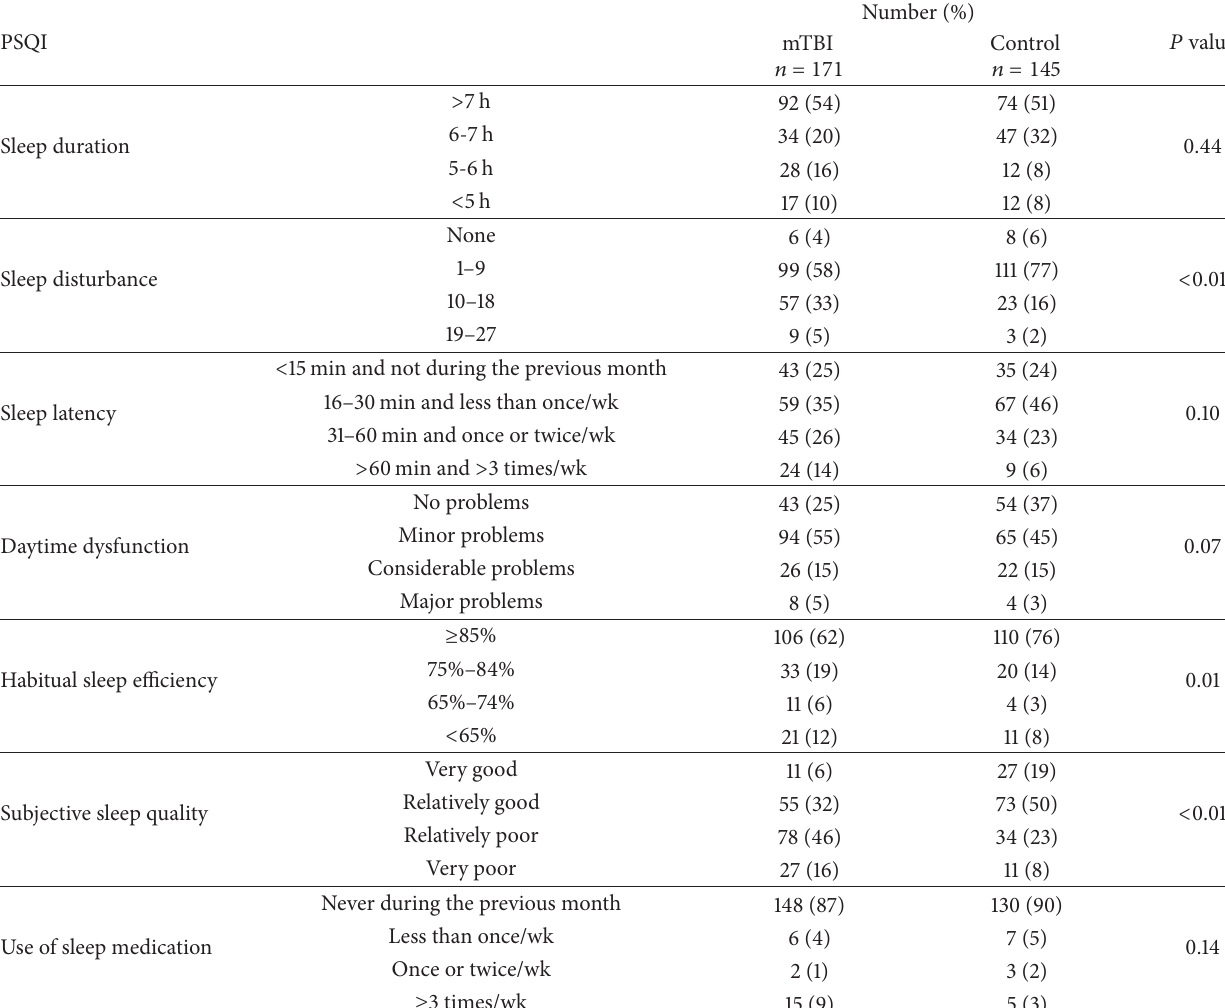
Table 2: Numbers (percentages) of participants with each PSQI subscore in the mTBI and control groups. PSQI